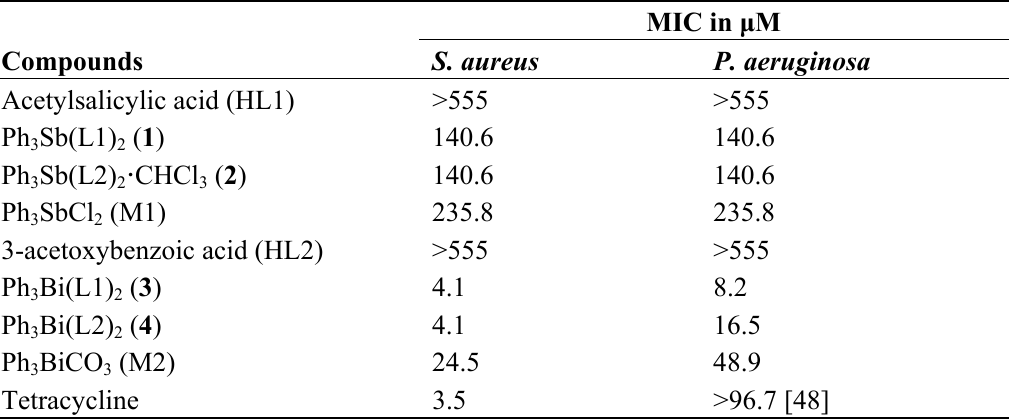
Table 4. Minimal inhibitory concentrations (MIC) for complexes 1 – 4 , their metal salts and the free ligands and starting materials towards Staphyloccocus aureus (ATCC 6538) and Pseudomonas aeruginosa (ATCC